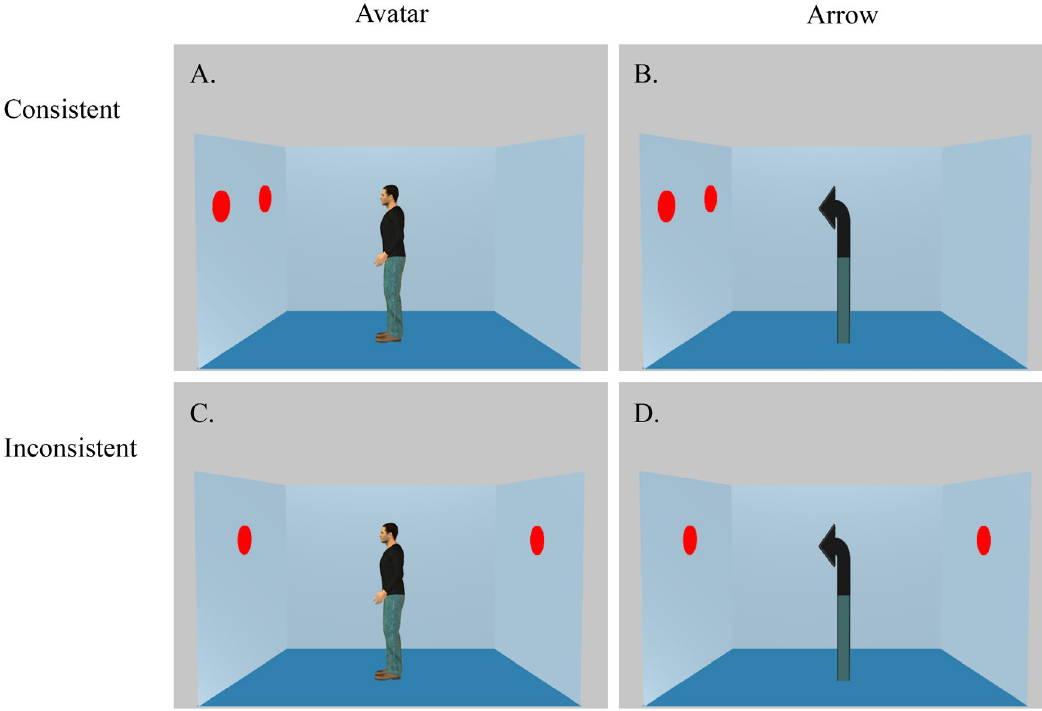
Figure 5. Examples of the stimuli presented in the different experimental conditions: Consistent ( A ) and Inconsistent ( C ) conditions with the Avatar, and Consistent ( B ) and Inconsistent ( D ) conditions with the